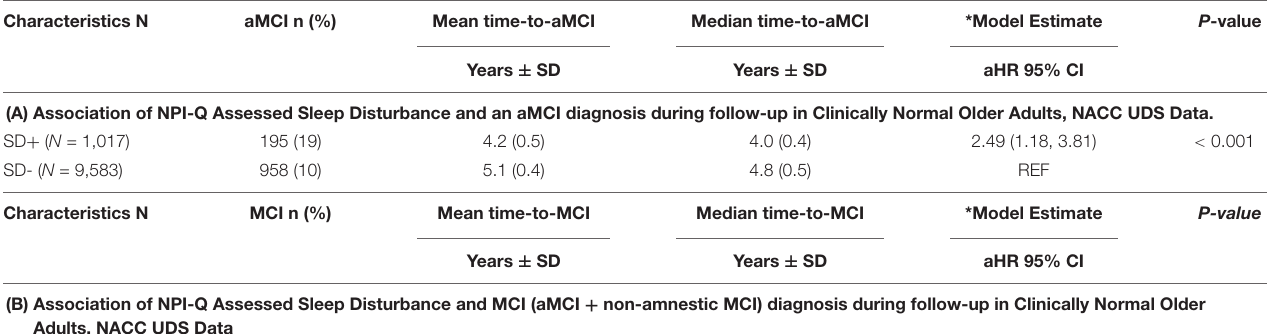
TABLE 2 | Association of NPI-Q assessed sleep disturbance (SD) and an MCI diagnosis during follow-up in clinically normal older adults, NACC UDS data. Characteristics N